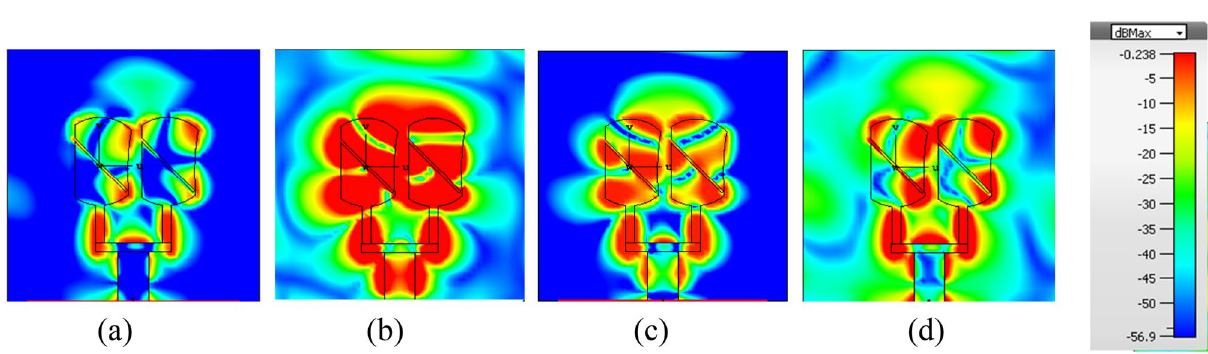
Figure 7. Variations of the E-field vs. various phases ( a ) 0°, ( b ) 90°, ( c ) 135°, ( d )